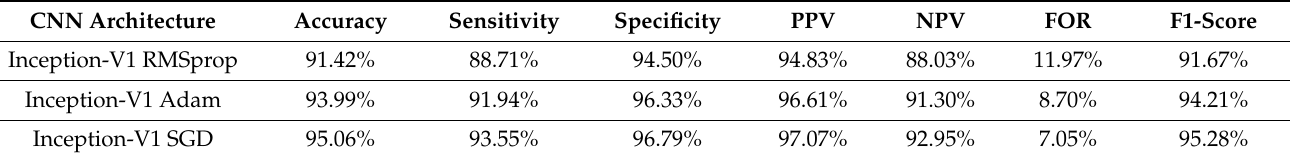
Table 11. Validation statistical analysis of the Inception-V1